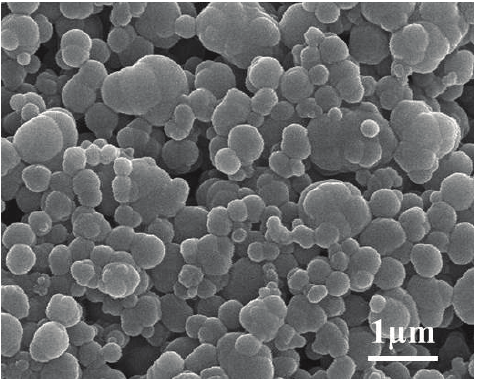
Figure 4. SEM micrographs of carbon.